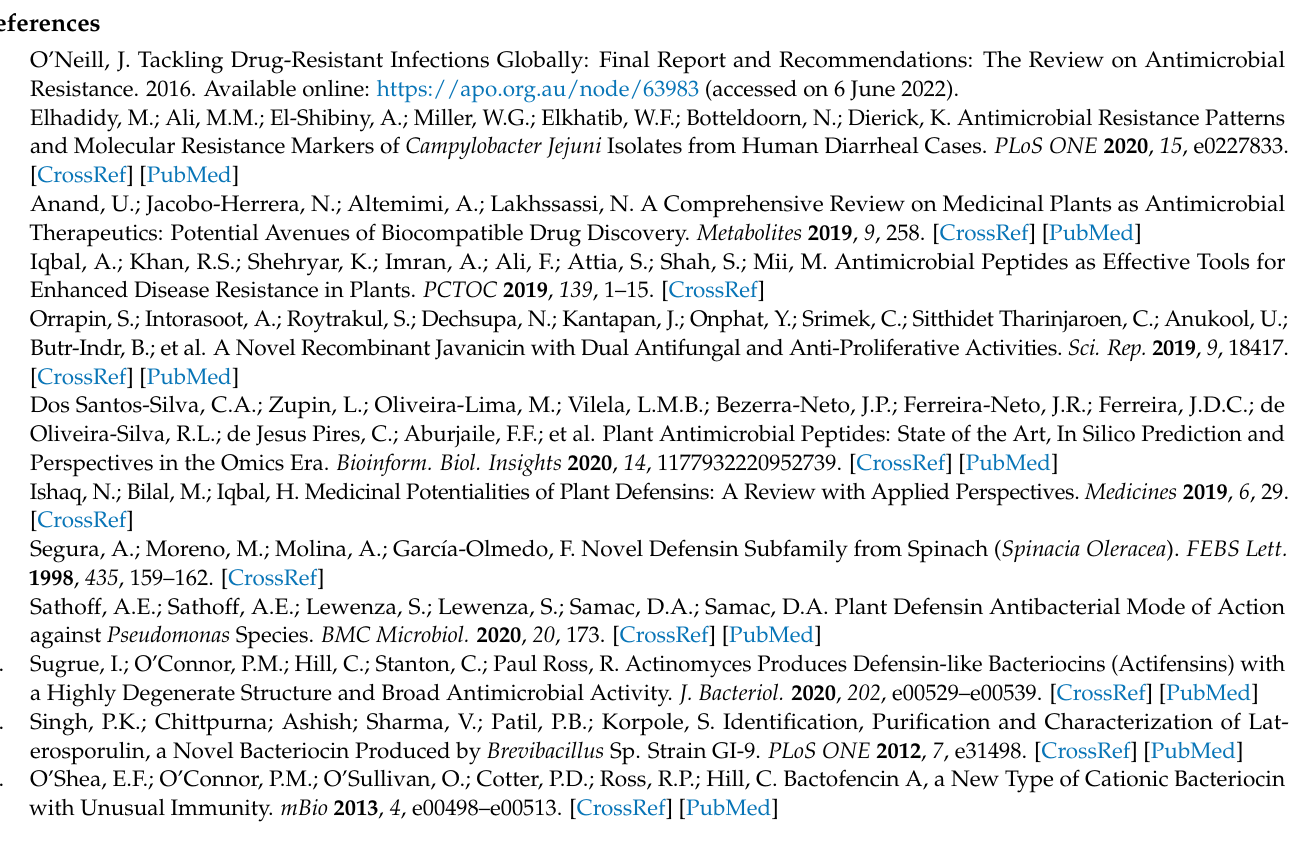
Table S1: Peptide-ligand affinity scores of defensin-d2 and